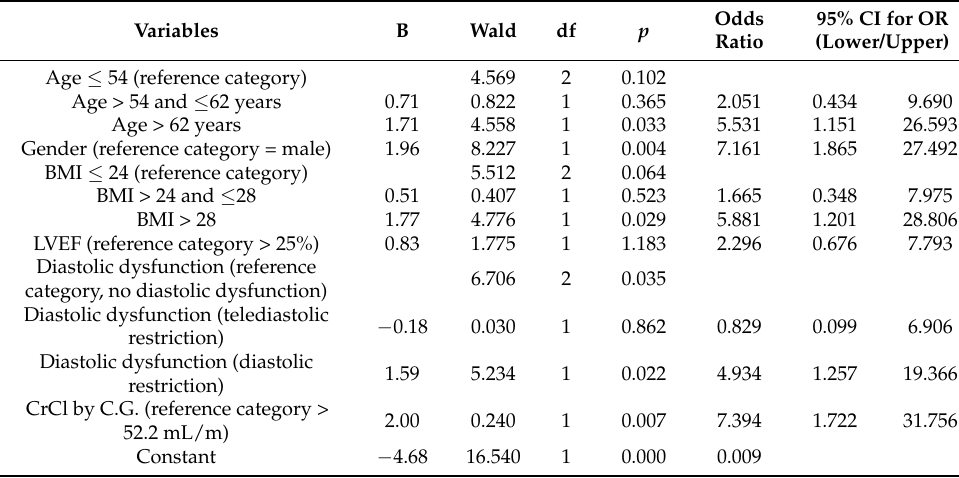
Table 5. Logistic regression predicting the likelihood of a VO 2 max ≤ 14